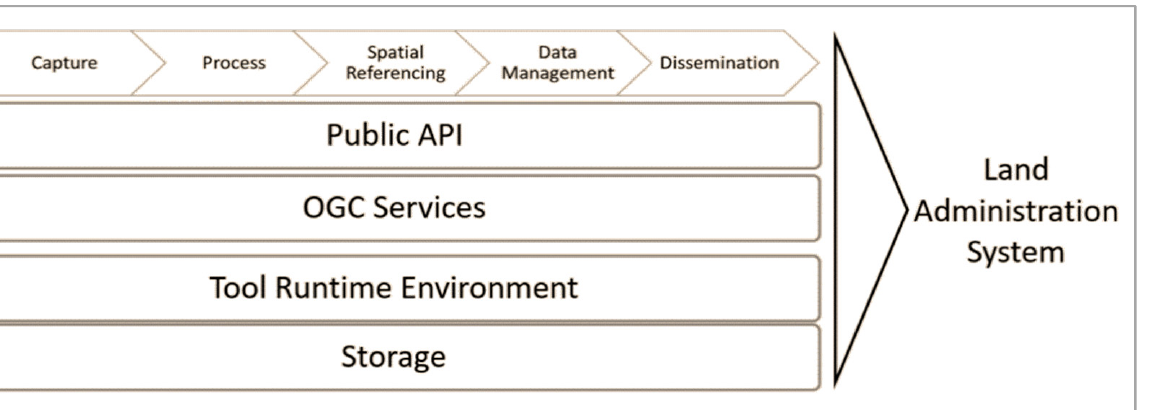
Table 2. Spatial data classes in PaS (X indicates support).